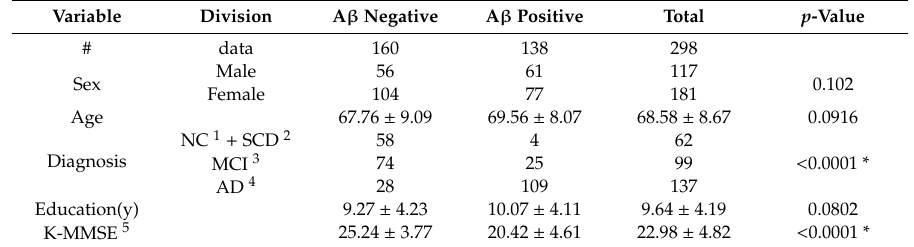
Table 1. Demographics of subjects who were photographed with FBB images retrospectively collected at Dong-A University